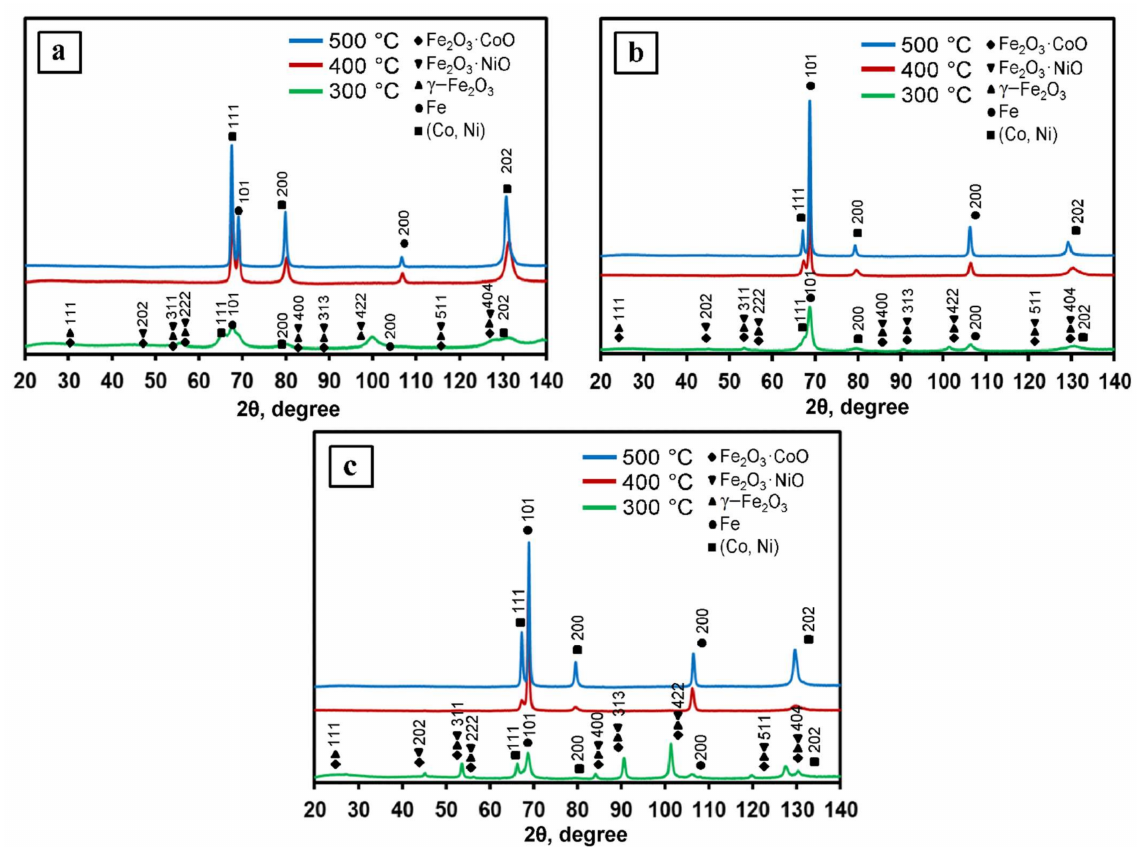
Figure 3. The Fe–Co–Ni nanocomposites’ x-ray diffraction (XRD) patterns reduced at 300–500 ◦ C. ( a ) 1Fe–Co–Ni, ( b ) 3Fe–Co–Ni, ( c )